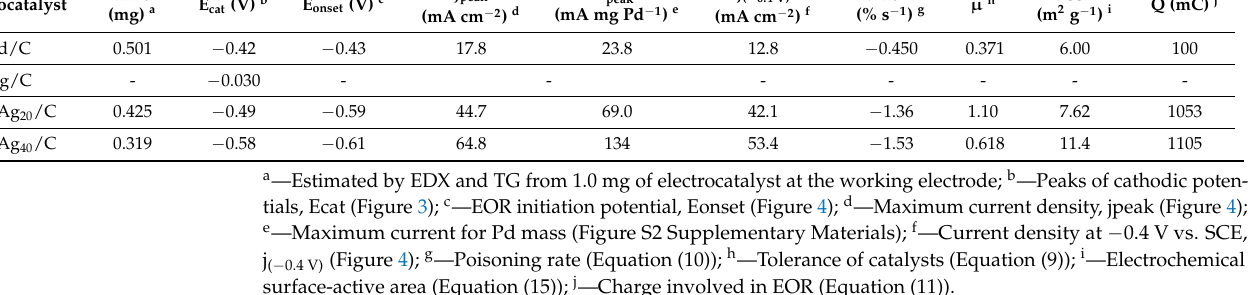
Table 4. Electrochemical data obtained by cyclic voltammetry and Figure 4 . Cyclic voltammograms of the electrocatalysts 40% Pd-based/C in N 2 -purged KOH 1.0 mol L −1 /ethanol at scan rate of 20 mV s −1 .